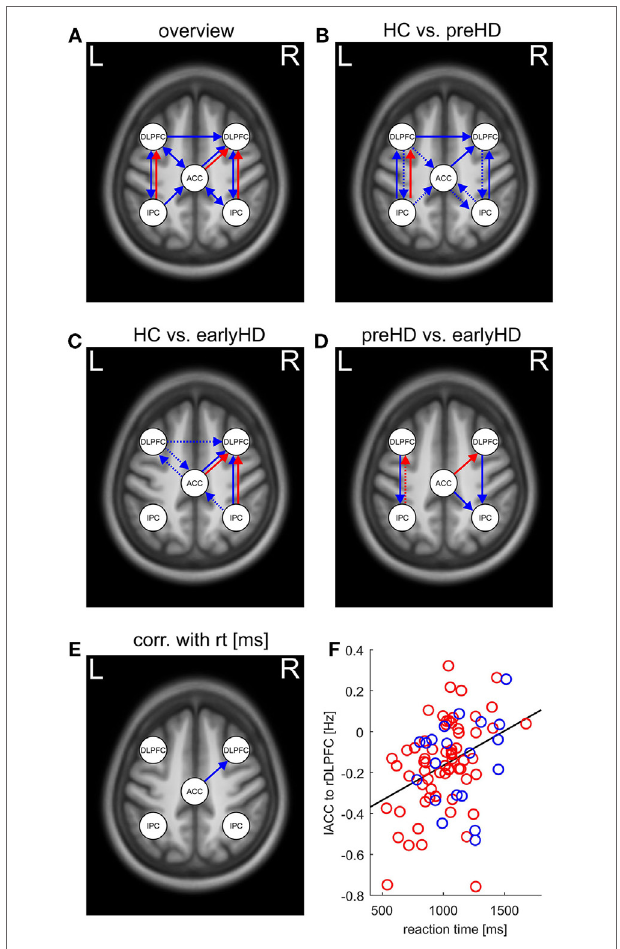
FigUre 3 | (a) Overview of between-group differences in intrinsic (blue arrows) and task-related (red arrows) effective connectivity ( p < 0.0014 after Bonferroni correction for 35 comparisons) as revealed by ANCOVA. (b–D) Pairwise comparisons and direction of differences in effective connectivity as revealed by post hoc tests (dotted arrows indicate decreased connectivity; solid arrows indicate correspondingly increased connectivity. “Decreased” and “increased” connectivity refers to the group that is named first, respectively). (b) Pairwise comparisons between healthy control (HC) and preHD, (c) pairwise differences between HC and earlyHD, and (D) pairwise comparisons between preHD and earlyHD. (e) Positive association between response time in the 2-back task and intrinsic connectivity as revealed by partial correlation analysis. (F) Scatter plot of the reaction time in the 2-back task and intrinsic connectivity between left anterior cingulate cortex (lACC) and right dorsolateral prefrontal cortex (rDLPFC), preHD participants are represented in red, and earlyHD patients in blue,